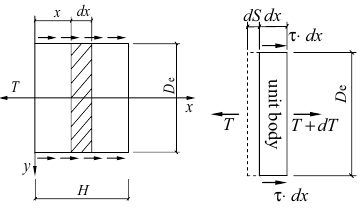
Figure 10. Analytical diagram of the load transfer of the anchor